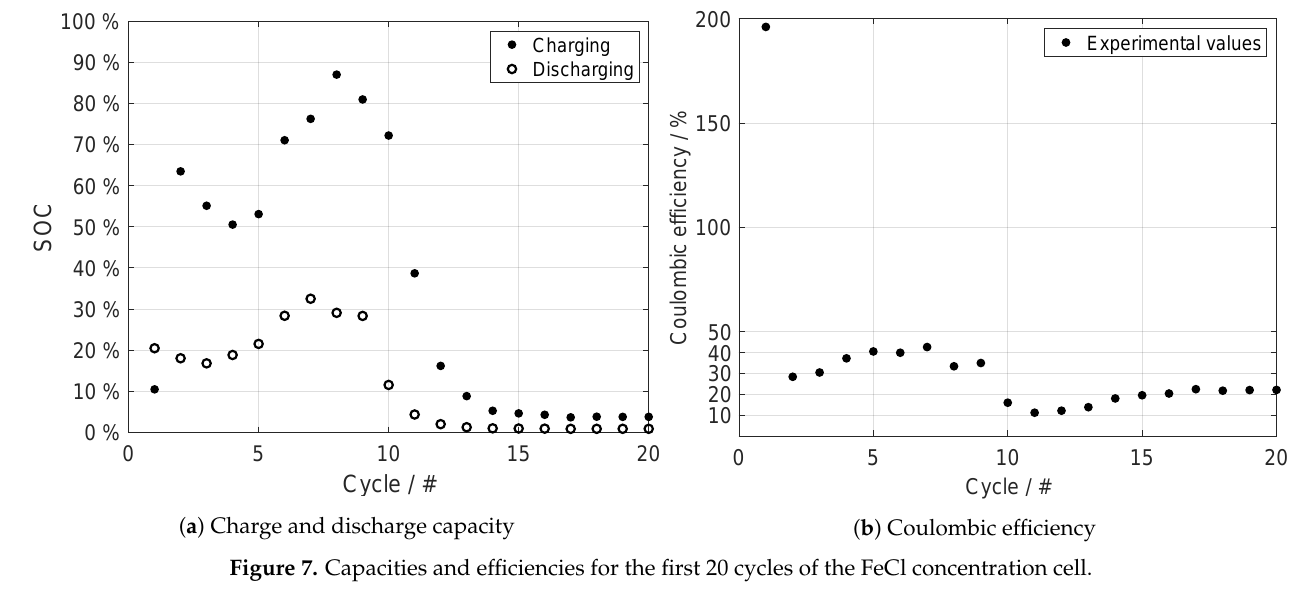
Figure 7. Capacities and efficiencies for the first 20 cycles of the FeCl concentration cell. The coulombic efficiency of cycling was obtained with open beakers. It should be repeated with closed beakers (foil on top) and while purged with nitrogen/argon/inert gas. Oxygen/air contamination is probably the reason for low efficiency. The discharge capacity of the battery in the first 10 cycles varies in a range of 16–32% of SOC. From cycle 10 and onward the discharge capacity decreases steadily. From cycle 14 on the